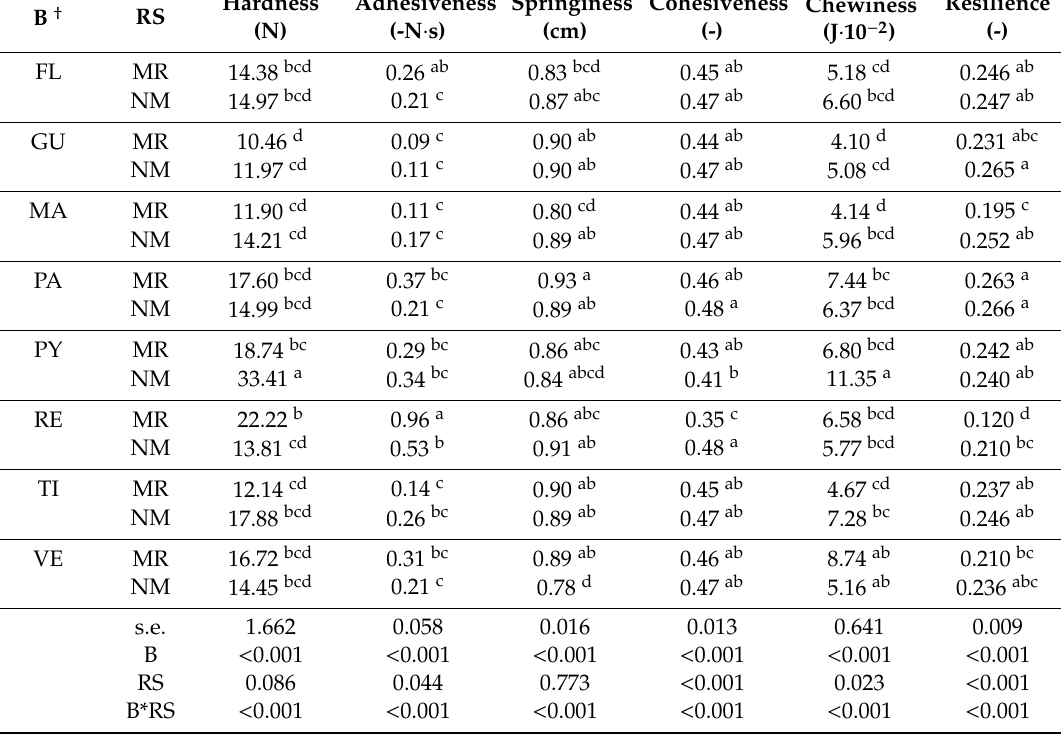
Table 3. Texture profile of raw longissimus lumborum muscle of suckling kids reared with milk replacer (MR) or natural milk from their dams